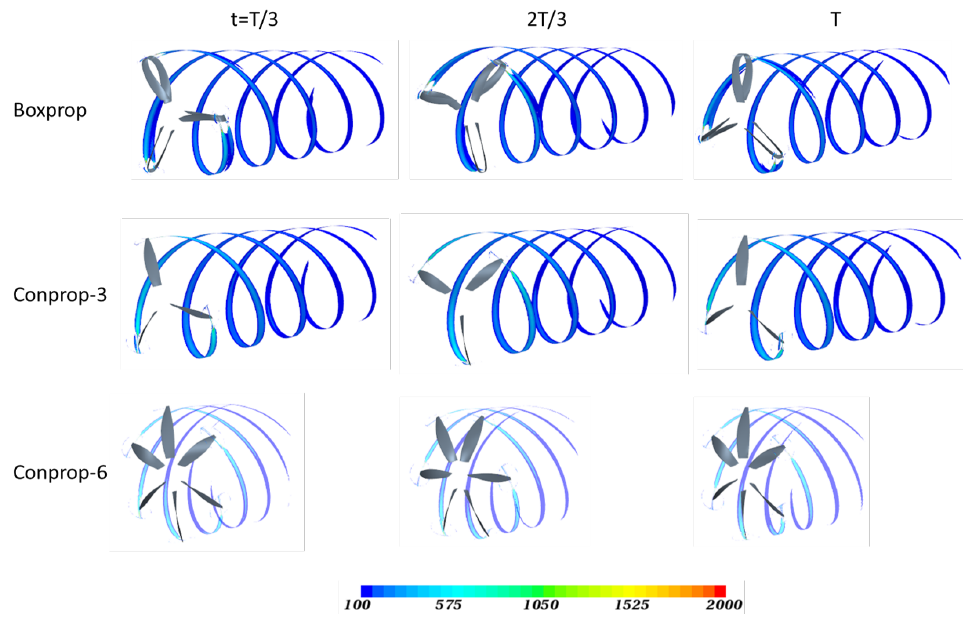
Figure 12. Contours of the instantaneous vorticity magnitudes at the radial position of r = 0.95 R , where R is the propeller radius. The snapshots from left to right: t = T /3, 2 T /3 and T . T denotes the propeller revolution period. Note that the contour levels outside the range between 100 and 2000 are clipped off